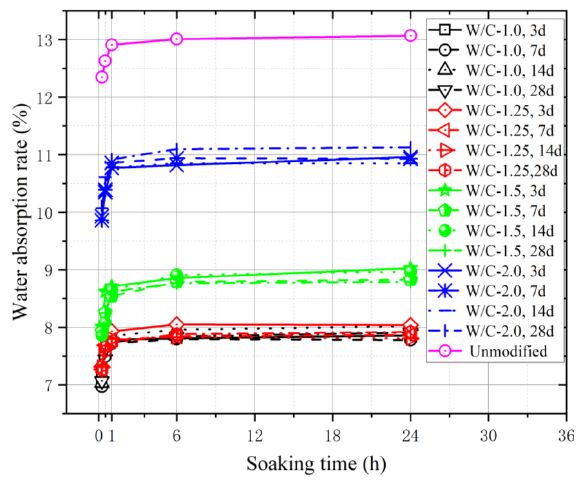
Figure 4. Water absorption of coral aggregates after different soak times.